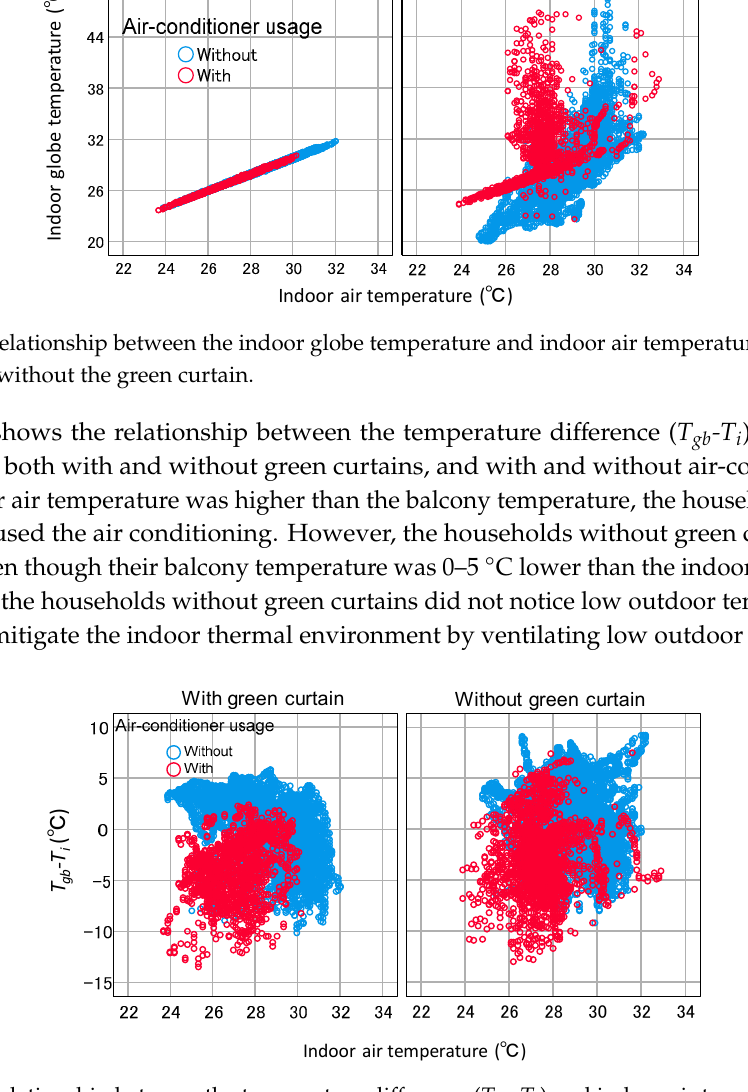
Figure 19. Relationship between the temperature difference ( T gb -T i ) and indoor air temperature with green curtain and without the green curtain.